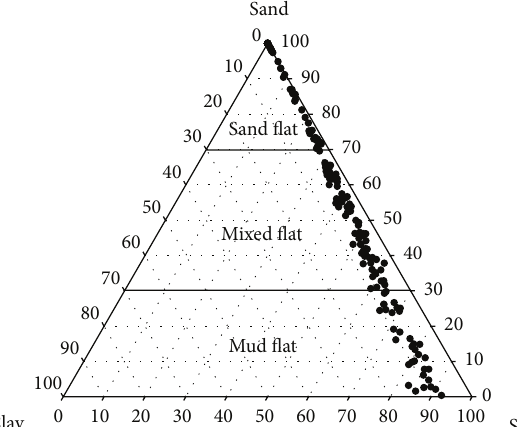
Table 2: Parameters for indicator variogram models.